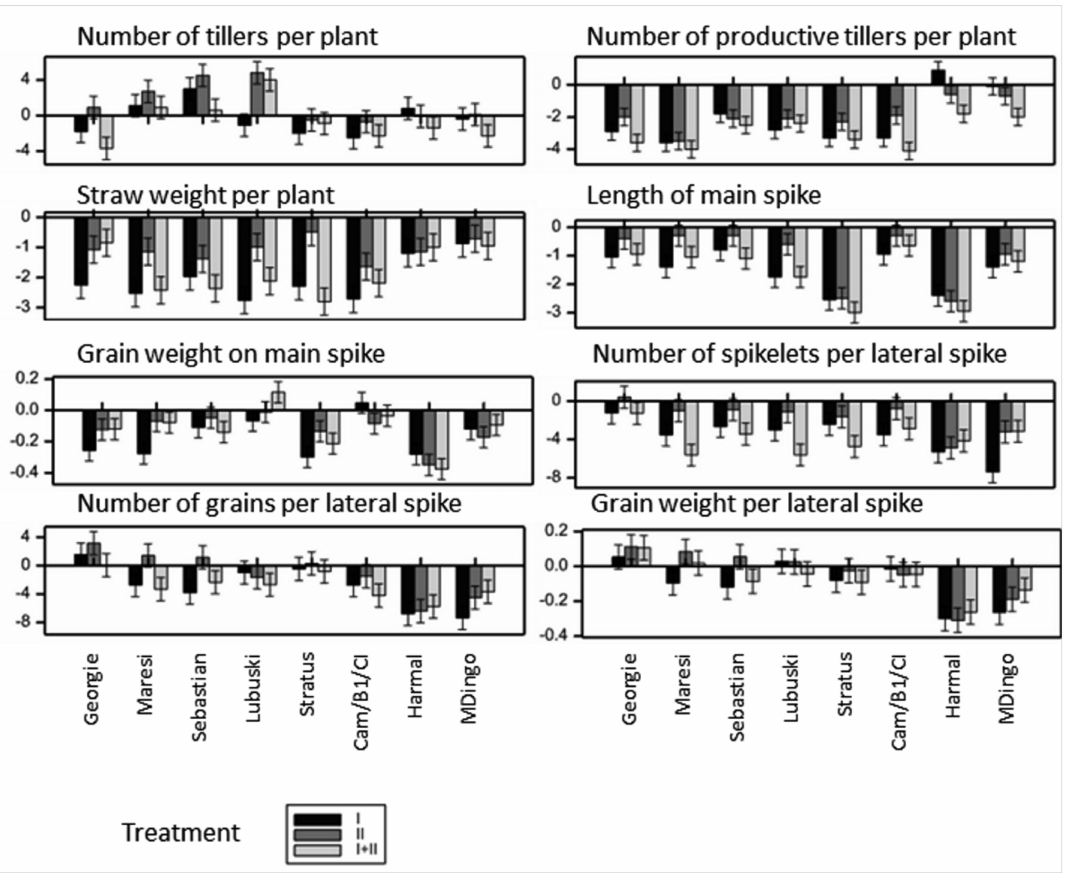
Figure 7. E ff ects of water deficiency under treatments I, II, I + II for phenotypic traits for which significant di ff erences among varieties were observed in at least one treatment ( p <